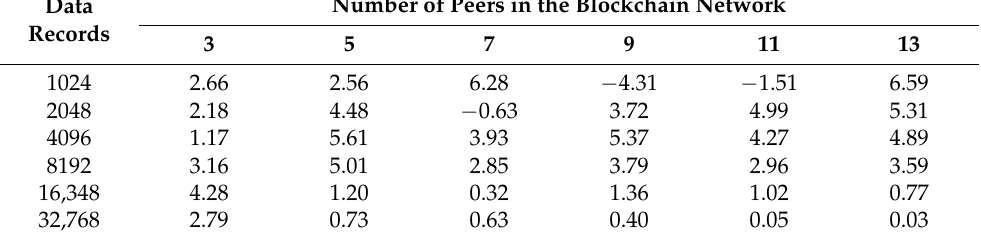
Table 3. Model inference overhead (in%) for the synthetic dataset, calculated as a median of 100 runtime ratios. The overall median from 3600 runs (6 × 6 × 100 runtime ratios) was 1.99% and the overhead was above zero for 69.15% of all runs.